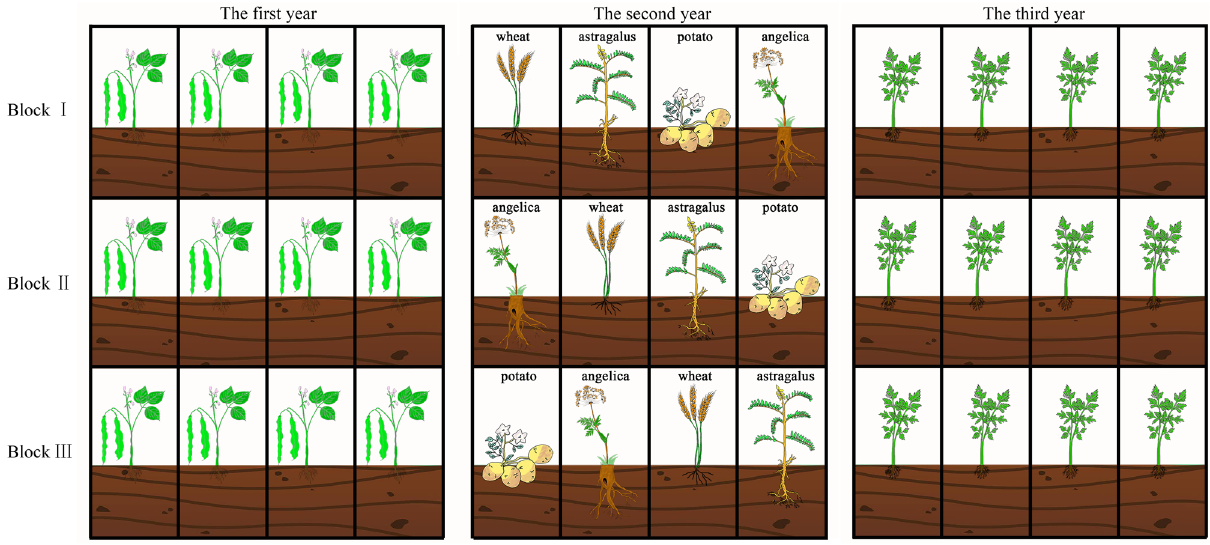
Figure 1. Schematic representation of the same field over time. The field was divided into three blocks. Each block contained four treatments, totaling 12 plots. The field were planted with broad bean in the first year, wheat, astragalus, potato and angelica in the second year, and Angelica sinensis seedlings in the third